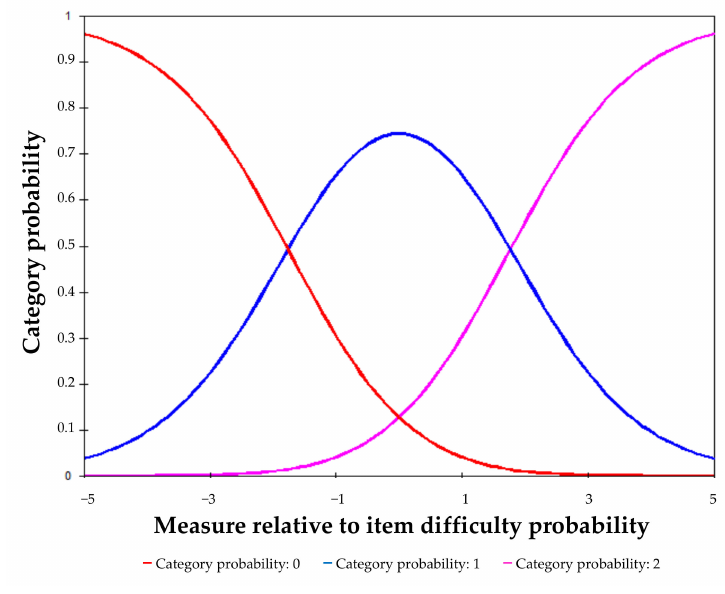
Figure 1. Category response probability curves for the CVS-Q IT©. Table 3. Item Rasch analysis results of the symptom severity